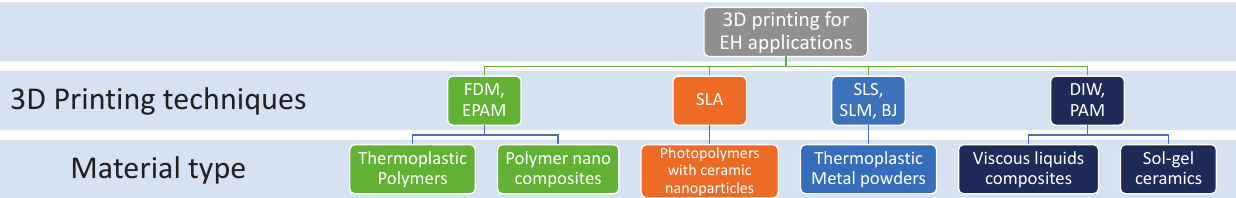
Figure 3. 3D printing techniques related to material type